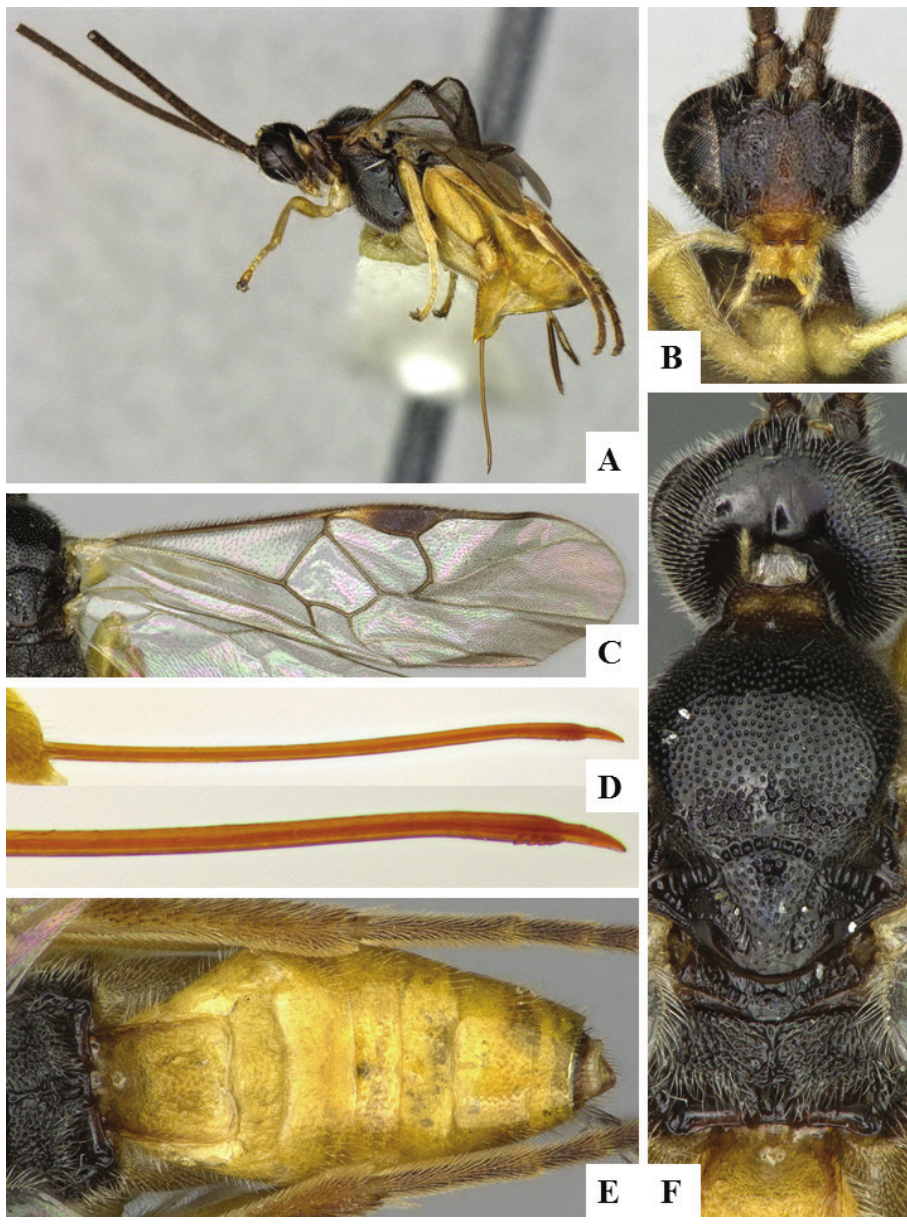
Figure 32. Ohenri gouletarum female holotype. A Habitus B Head frontal C Fore wing D Ovipositor and details of ovipositor tip E Metasoma dorsal F Mesosoma